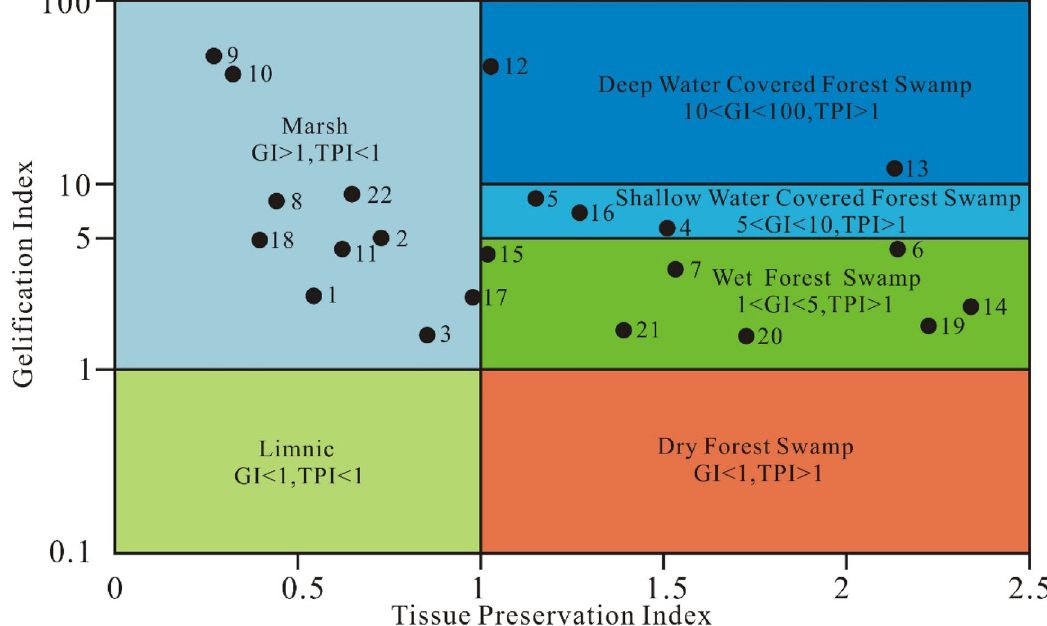
Fig. 5 Coa-forming swamp interpretation based on TPI and GI in Hanshuiquan district, Santanghu Coalfield, NW China. Modified by Diessel